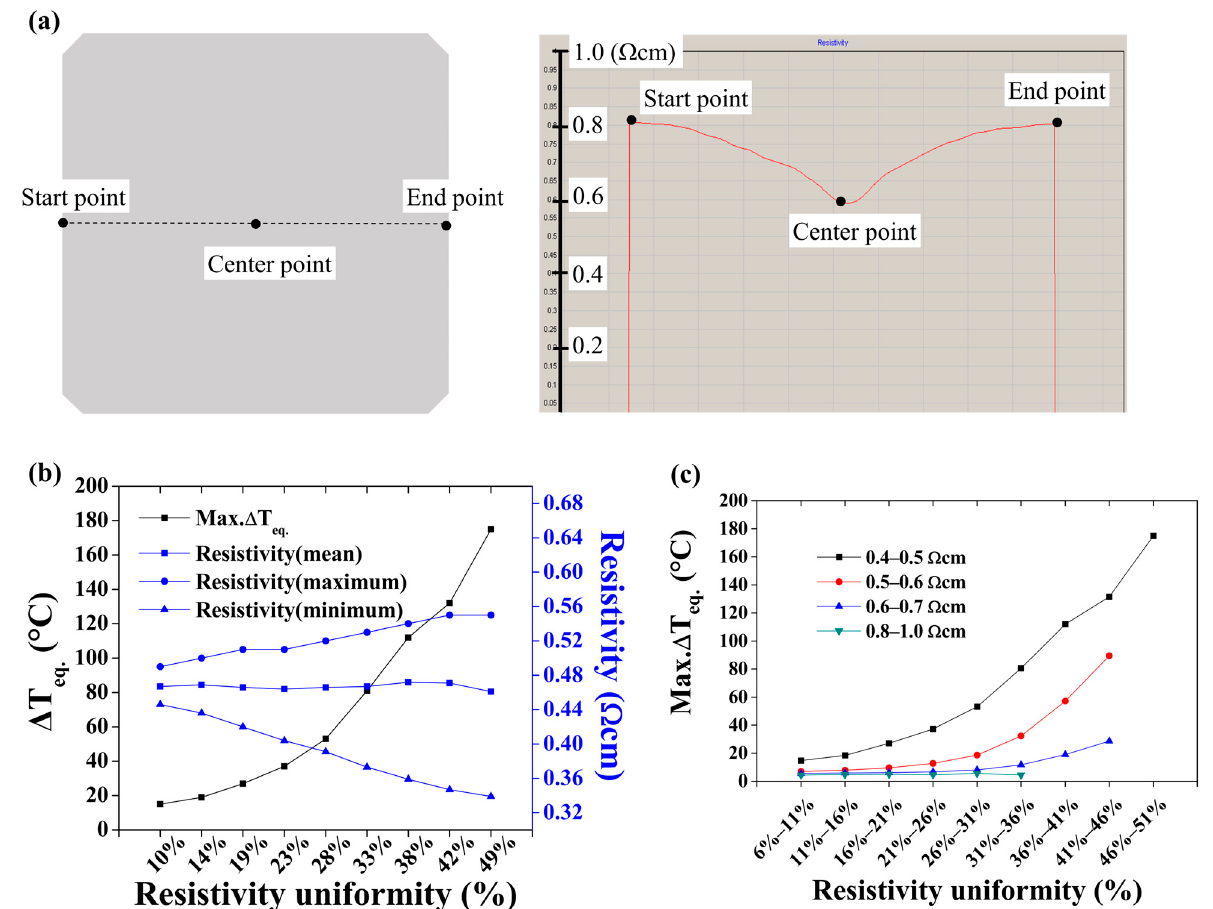
Figure 3 . ( a ) The left panel shows the resistivity scanning path diagram of the silicon wafer, and the Figure 3. ( a ) The left panel shows the resistivity scanning path diagram of the silicon wafer, and right panel shows the distribution curve of the resistivity displayed by the device after scanning the the right panel shows the distribution curve of the resistivity displayed by the device after scanning gallium-doped silicon wafer; ( b ) the correlation curve of the resistivity, 𝑀𝑎𝑥. ∆𝑇 (cid:3032)(cid:3044). , the minimum the gallium‑doped silicon wafer; ( b ) the correlation curve of the resistivity, Max . ∆ T eq . , the minimum resistivity, the maximum resistivity, and the resistivity uniformity for the 0.4 – 0.5 Ω cm (100 Ω /sq) resistivity, the maximum resistivity, and the resistivity uniformity for the 0.4–0.5 Ω cm (100 Ω /sq) gallium-doped silicon wafer PERC cells; ( c ) the variation curve of the 𝑀𝑎𝑥. ∆𝑇 (cid:3032)(cid:3044). versus the resis- gallium‑doped silicon wafer PERC cells; ( c ) the variation curve of the Max . ∆ T eq . versus the resistivity tivity uniformity for the gallium-doped PERC cells at different resistivities (100 Ω /sq). uniformity for the gallium‑doped PERC cells at different resistivities (100 Ω /sq). Figure 4 maps the equilibrium temperature increase ( ∆𝑇 (cid:3032)(cid:3044). ) of the gallium-doped Figure 4mapstheequilibriumtemperatureincrease ( ∆ T eq . ) of the gallium‑doped PERC PERC cells with a resistivity of 0.4 – 0.5 Ω cm and a sheet resistance of 100 Ω /sq under dif- cells with a resistivity of 0.4–0.5 Ω cm and a sheet resistance of 100 Ω /sq under different ferent resistivity uniformities, which shows that the locations of 𝑀𝑎𝑥. ∆𝑇 (cid:3032)(cid:3044). were concen- resistivity uniformities, which shows that the locations of Max . ∆ T eq . were concentrated trated at the center of the cells, consistent with the position of the lowest resistivity shown at the center of the cells, consistent with the position of the lowest resistivity shown in in Figure 3a. As the uniformity changed from 14% to 49%, ∆𝑇 (cid:3032)(cid:3044). at the center increased Figure 3a. As the uniformity changed from 14% to 49%, ∆ T eq . at the center increased sig‑ significantly, while no obvious differences were observed at other positions. Combined nificantly, while no obvious differences were observed at other positions. Combined with the conclusion in Figure 3, it is obvious that the central resistivity decreased significantly as the resistivity uniformity deteriorated, and the difference between the central and sur‑ rounding resistivities intensified. The avalanche breakdown occurred first in the central low‑resistivity region of the gallium‑doped PERC cell, concentrating the breakdown cur‑ rents in the central region. Therefore, the overall reverse current change was not obvious, but a high‑density reverse current region formed at the center as the breakdown point shrank, generating a large amount of Joule heat and forming an obvious central hot spot spot in the gallium-doped PERC cell. in the gallium‑doped PERC